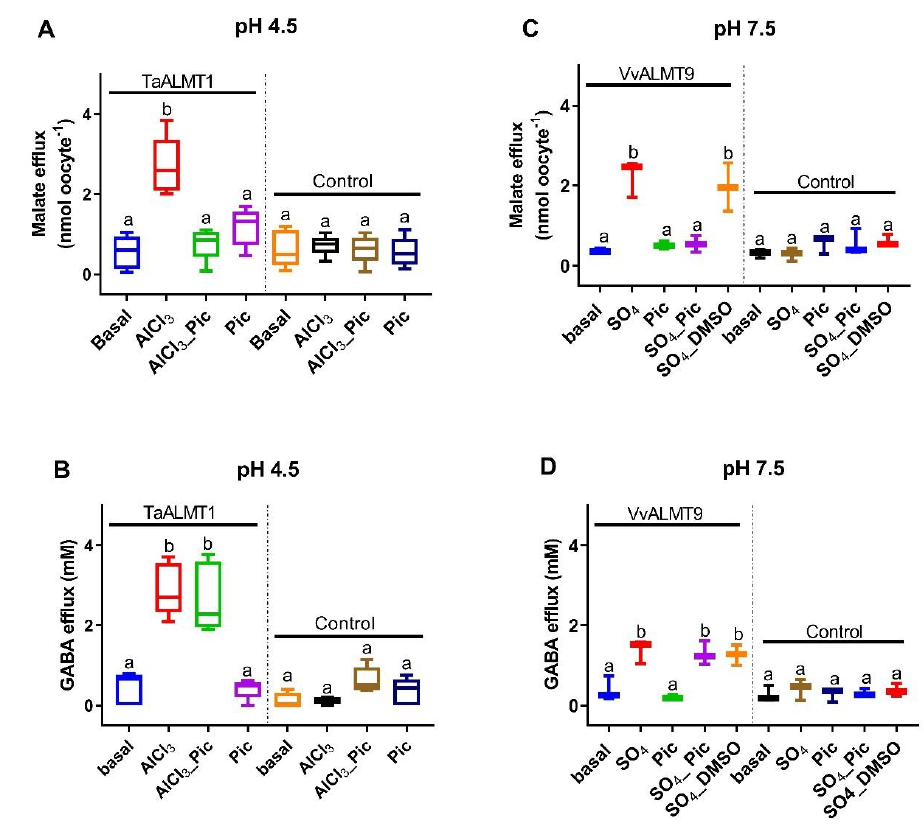
Figure 2. Malate efflux from Xenopus oocytes expressing ALMTs is blocked by picrotoxin (Pic, 10 µ M) but not GABA efflux. ( A , B ) TaALMT1 where malate and GABA efflux is activated by AlCl 3 (100 µ M). ( C , D ) VvALMT9 is not activated by AlCl 3 but can be activated by adding 10 mM Na 2 SO 4. The dimethyl sulfoxide (DMSO) used to dissolve the picrotoxin had no effect on malate or GABA efflux. Controls are water-injected oocytes. Data shown for TaALMT1 ( n = 5) and VvALMT9 ( n = 3) are box plots, with different letters representing significant differences based on one-way ANOVA.